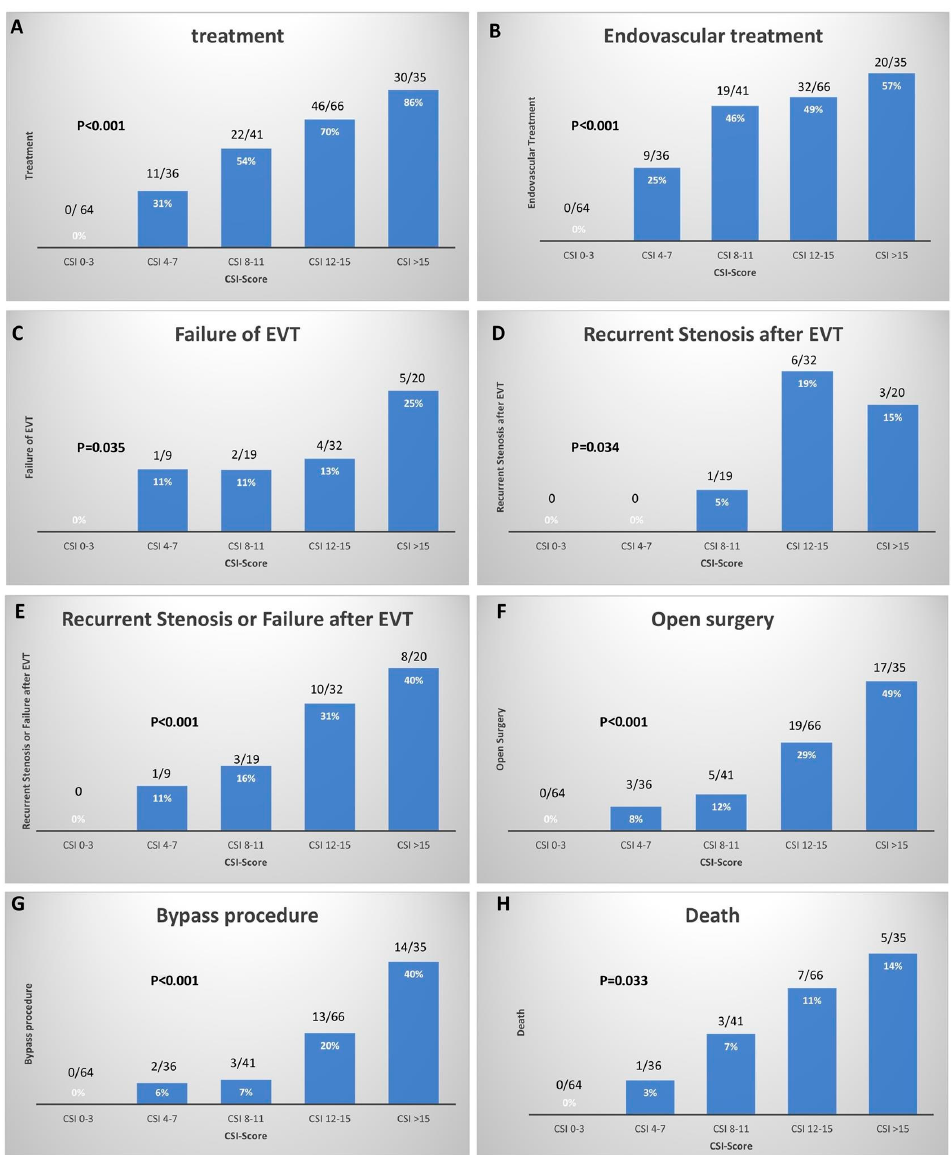
Figure 4. The histograms show the number and rates of patients in five CSI-score subgroups (0–3, 4–7, 8–11, 12–15, >15) stratified by treatment ( A ), endovascular treatment (EVT) ( B ), failure of EVT ( C ), recurrent stenosis after EVT ( D ), recurrent stenosis or failure after EVT ( E ), open surgery ( F ), bypass procedure ( G ), and death ( H ).